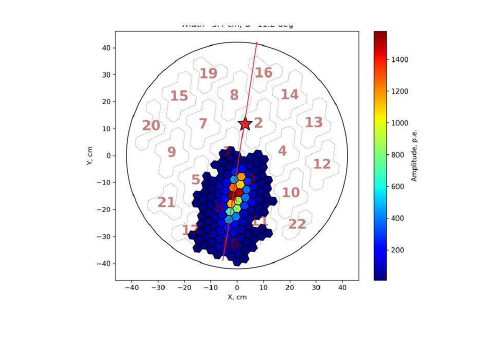
Figure 3. Example of a hadron-like joint event. Image parameters: Size = 18500 p.e., Width = 0.4 ◦ , Alfa = 11 ◦